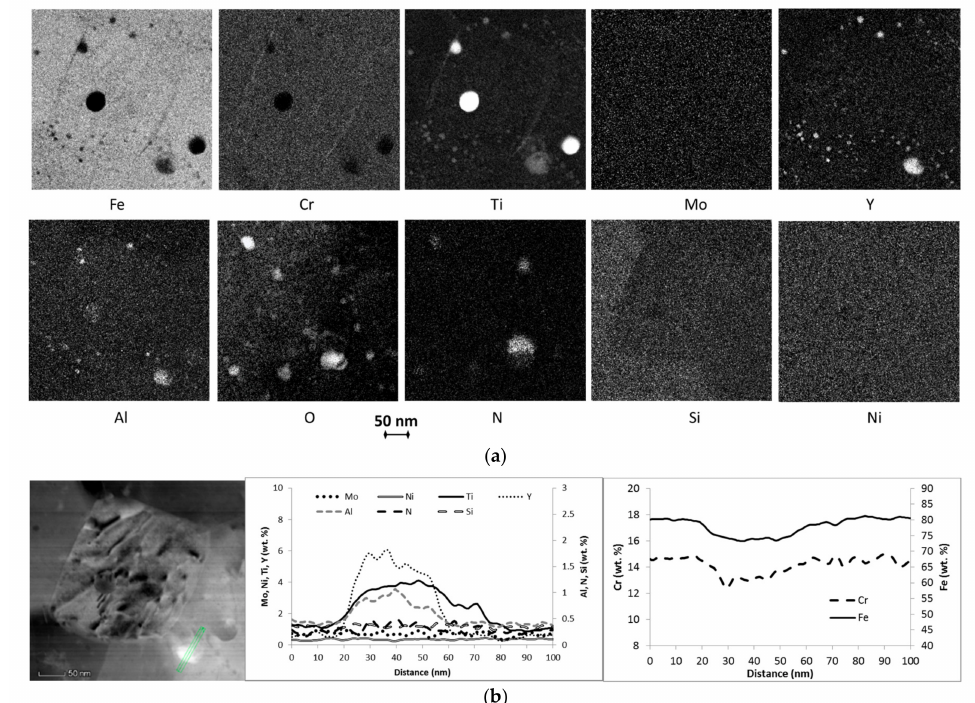
Figure 3. STEM-EDX maps of chemical elements determined in the AR sample: ( a ) The maps show variable composition of fine and coarser precipitates and grain boundary segregation elements; ( b ) STEM-EDX line scan of the coarser precipitate at the grain boundary shows depletion of Cr and Fe and enrichment of Al, Ti, and Y in the precipitate.